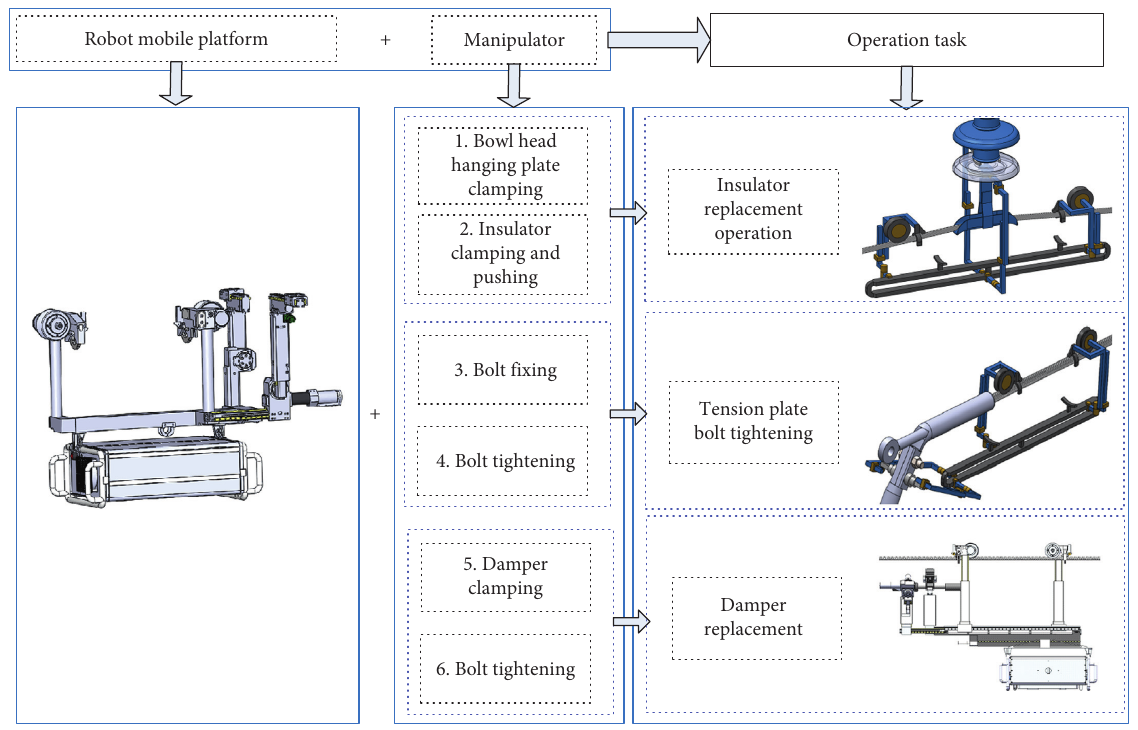
Figure 5: The principle of reconfigurable modular design for multiple tasks.